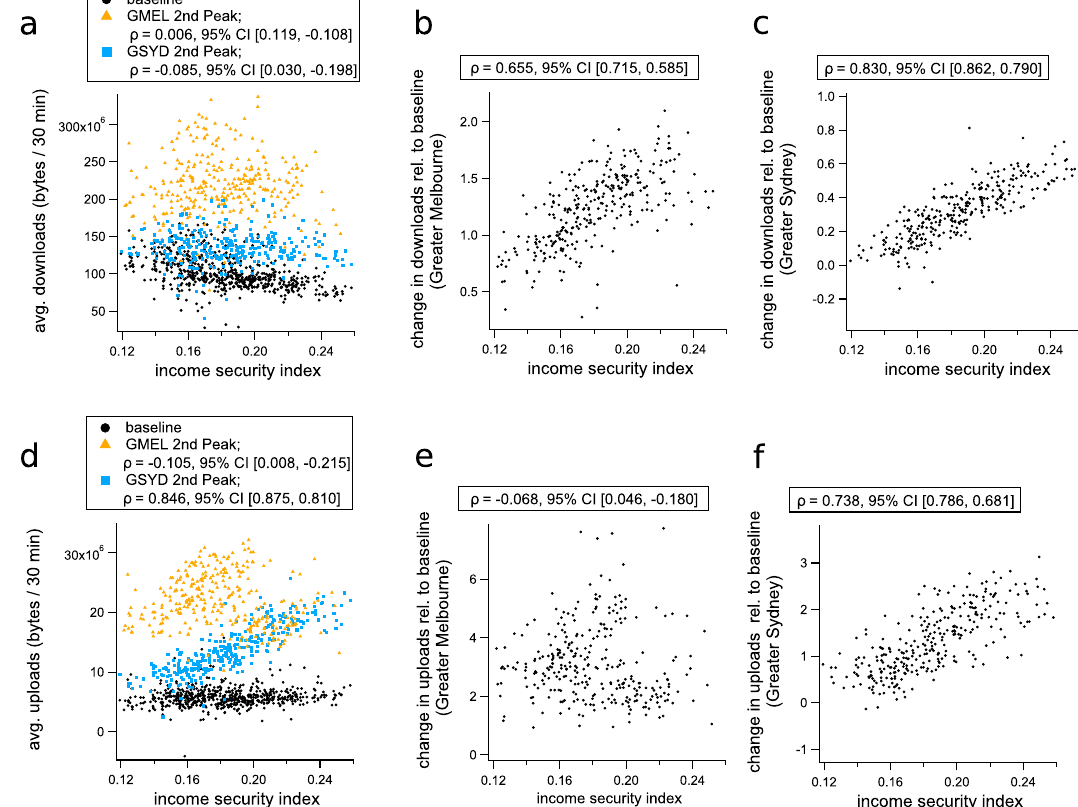
Figure 6. Changes to internet use during the second wave of COVID-19 restrictions in Australia, plotted against income security for each SA2 region. ( a ) Shows absolute download volumes averaged over the baseline period and second wave of COVID-19 restriction policies (August 8th to August 14th, 2020), which includes baseline (black dots), 2nd wave values for Greater Sydney (blue squares), and second wave values for Greater Melbourne (orange triangles). Plots ( b ) and ( c ) show the change in download volumes relative to pre-COVID baseline as a function of income security index for each SA2 in Sydney and Melbourne, respectively. Plots ( d ), ( e ) and ( f ) show the same analysis as ( a ), ( b ), and ( c ), respectively, for uploads rather than downloads. In each subplot, the internet traffic quantifiers are plotted against the income security score for the corresponding SA2 region, and Pearson’s correlation coefficients with 95% CI intervals are shown in the